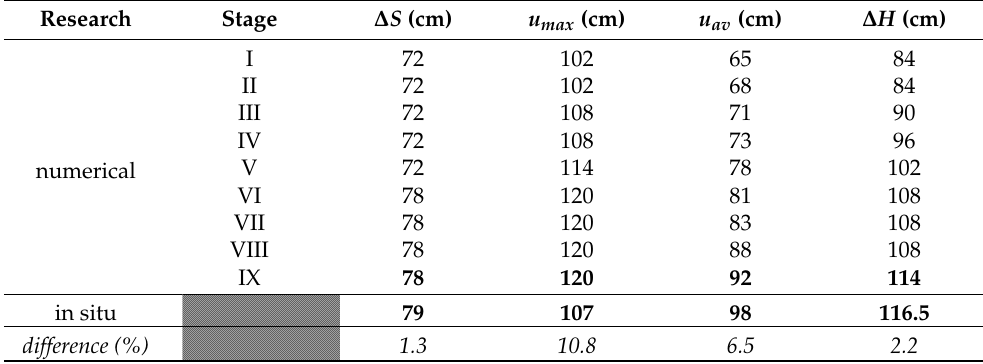
Table 7. Geomechanical parameters of claystone from the floor of the roadway F-33 versus time of soaking with water.